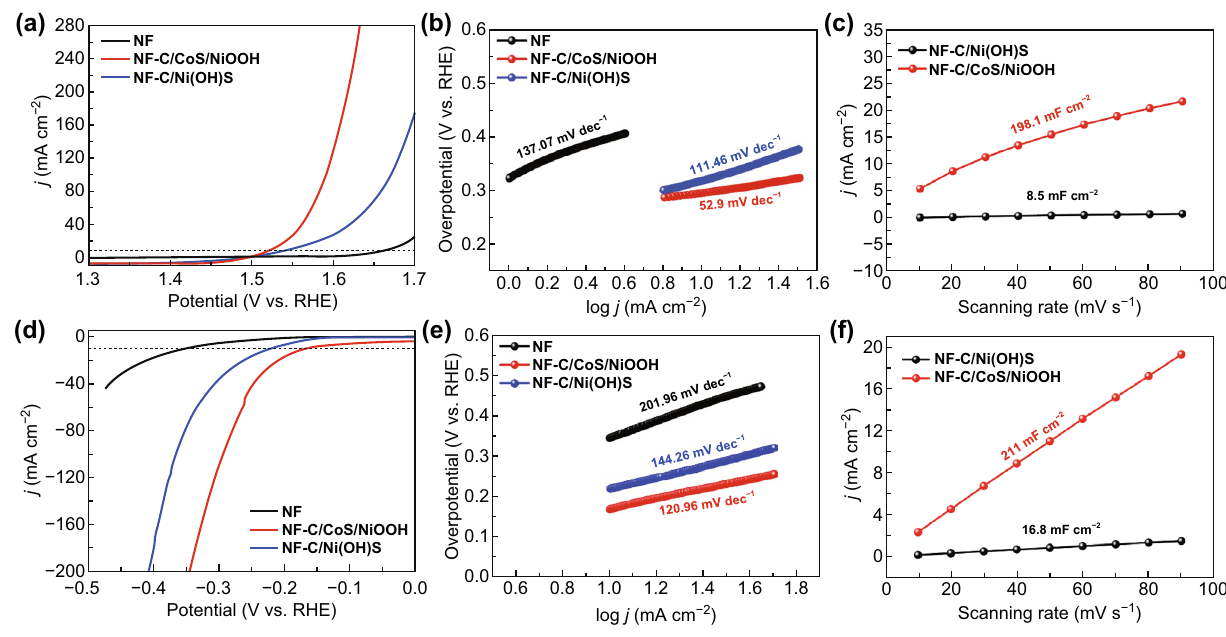
Fig. 5 a Polarization curves and b Tafel slopes of OER on bare NF, NF-C/CoS/NiOOH, and NF-C/Ni(OH)S. c C dl of OER on NF-C/CoS/ NiOOH and NF-C/Ni(OH)S. d Polarization curves and e Tafel slopes of HER on bare NF, NF-C/CoS/NiOOH, and NF-C/Ni(OH)S. f C dl of HER on NF-C/CoS/NiOOH and